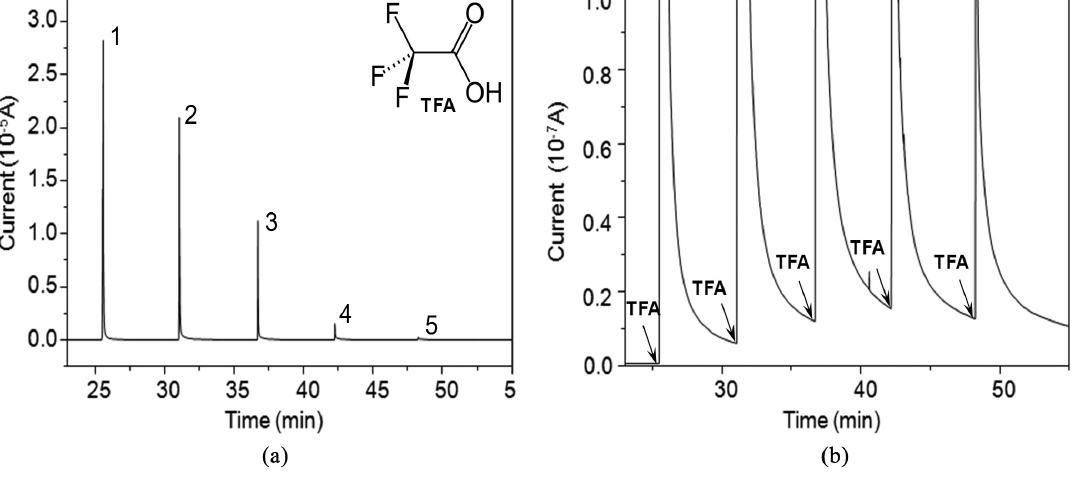
Figure 9. (a) Increase and decrease of the current as a function of TFA injections (5 injections). Inset: TFA molecular structure. (b) Zoom for lower current values of the curves shown in (a).